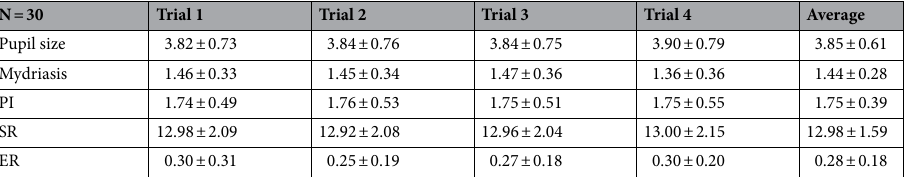
Table 1. Mean ± SD of pupil size and performance parameters obtained in four different experiments (Trial 1–4) performed in 30 subjects. PI performance index, SR scanning rate, ER error rate.